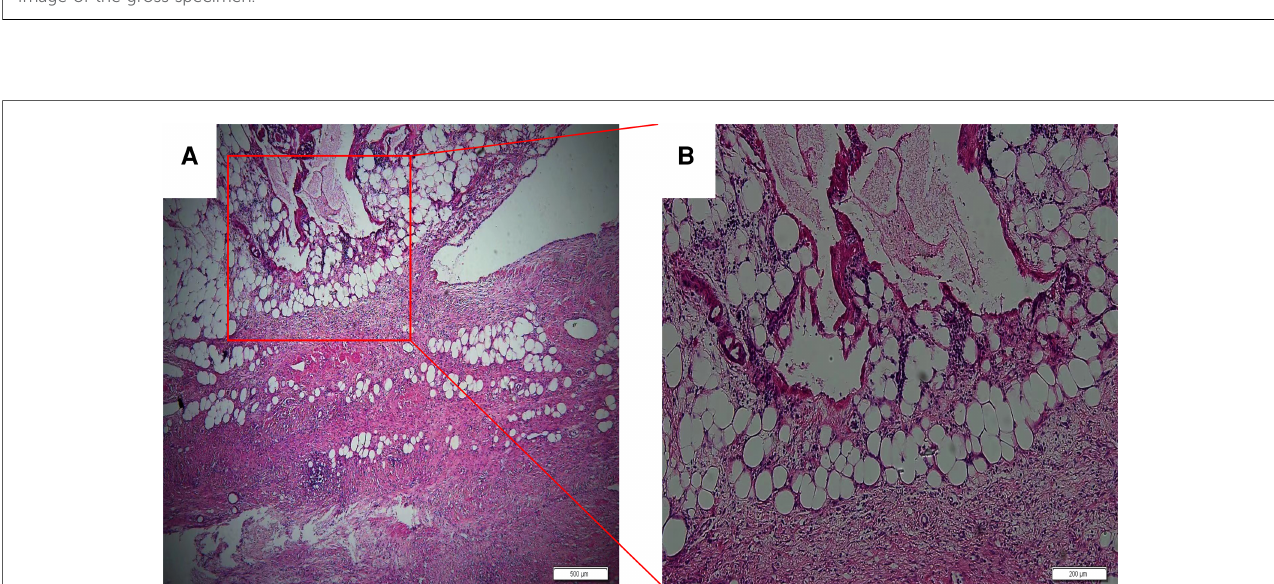
FIGURE 2 Image of the gross specimen.